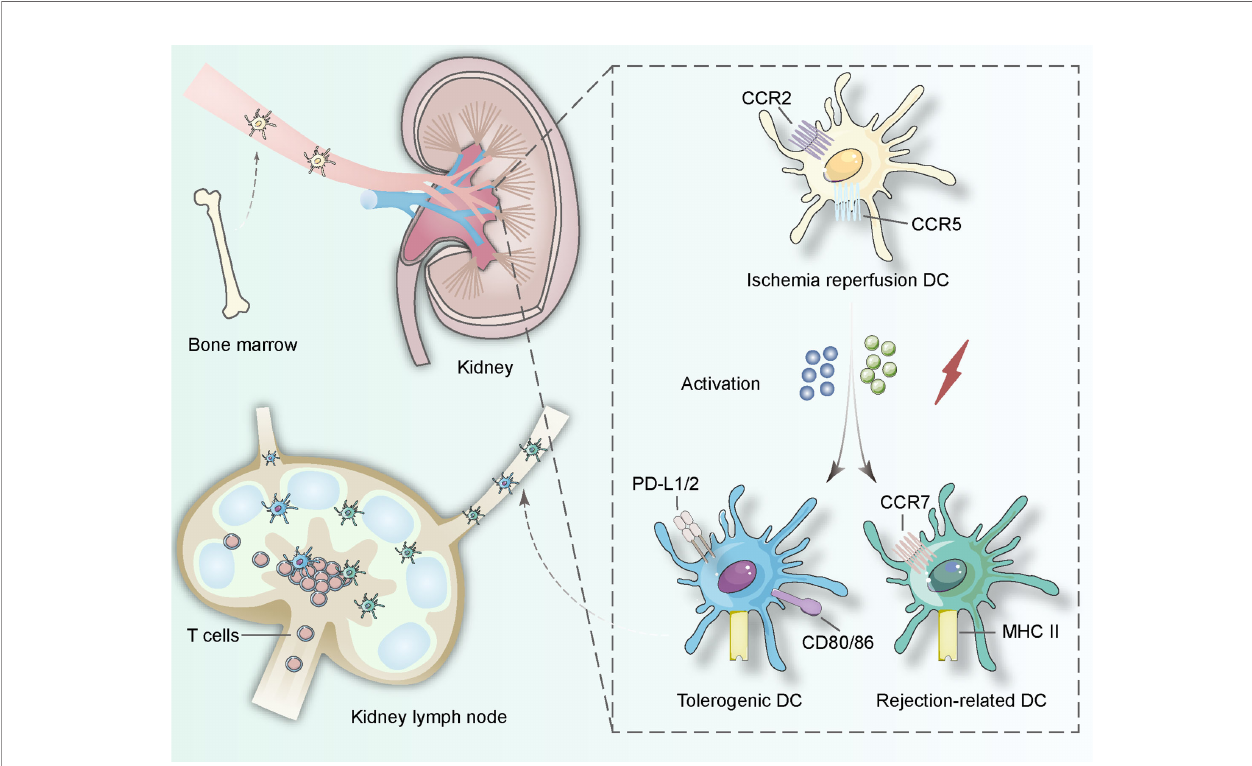
FIGURE 1 | DCs in the kidney originate from bone hematopoietic stem cells and involve in lymphatic recycling in vivo . When ischemia – reperfusion occurs, immature DCs start to search for interactions with T lymphocytes and change their surface proteins including CCR2, CCR5 to induce tolerance procedure (expressing PD-L1/2 and CD80/86) or rejection procedure (expressing CCR7 and MHC class II). The activation can be derived from pathogen-associated molecular patterns and danger- associated molecular patterns in the procedure of